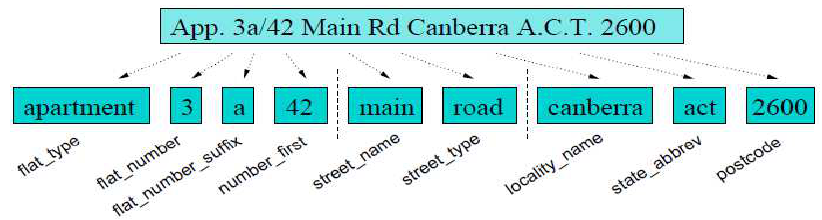
Figure 2. Detailed Australian address tag—an example.